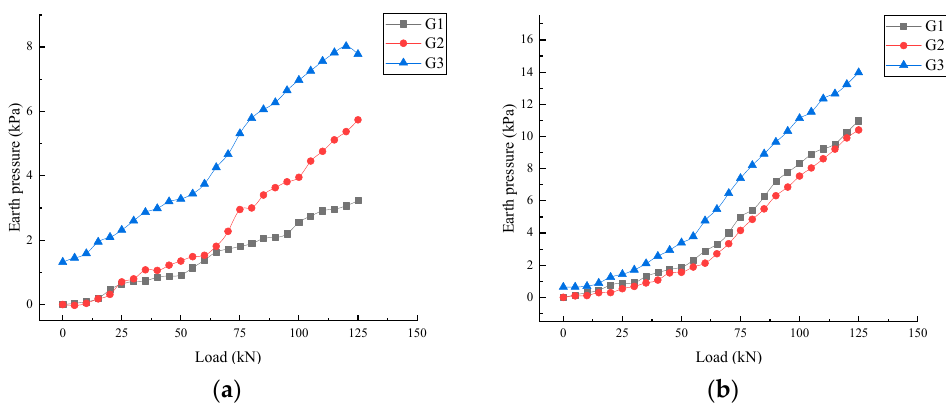
Figure 12. Earth pressure at representative measurement points in each group of tests. ( a ) Measurement point S6. ( b ) Measurement point S7.